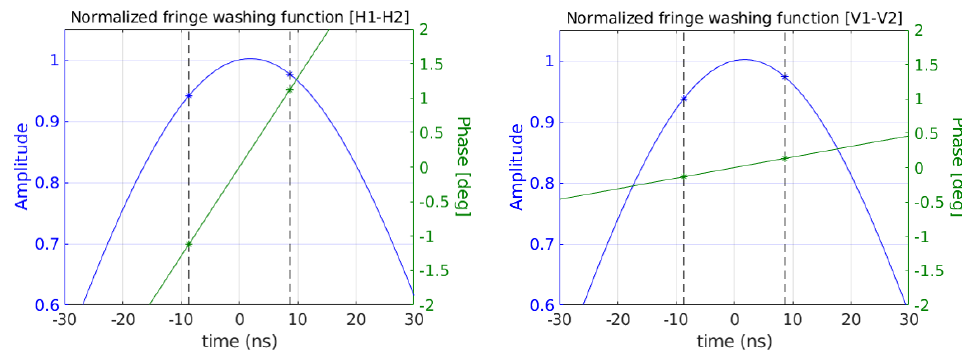
Figure 12. Normalized fringe washing function for baselines H1-H2 and V1-V2. The rest of the baselines have similar functions.